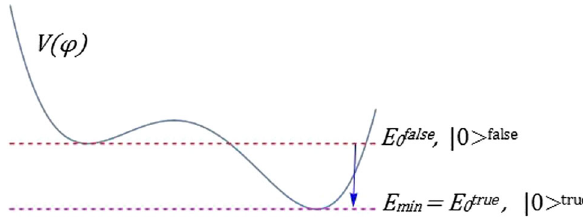
Fig. 1 Transition of the system from the false vacuum state | 0 (cid:5) false to the true ground state of the system, i.e. the true vacuum state | 0 (cid:5) true . The states | 0 (cid:5) false and | 0 (cid:5) true correspond to the local minimum and to the true lowest minimum of the potential V (ϕ) of the scalar field ϕ ,